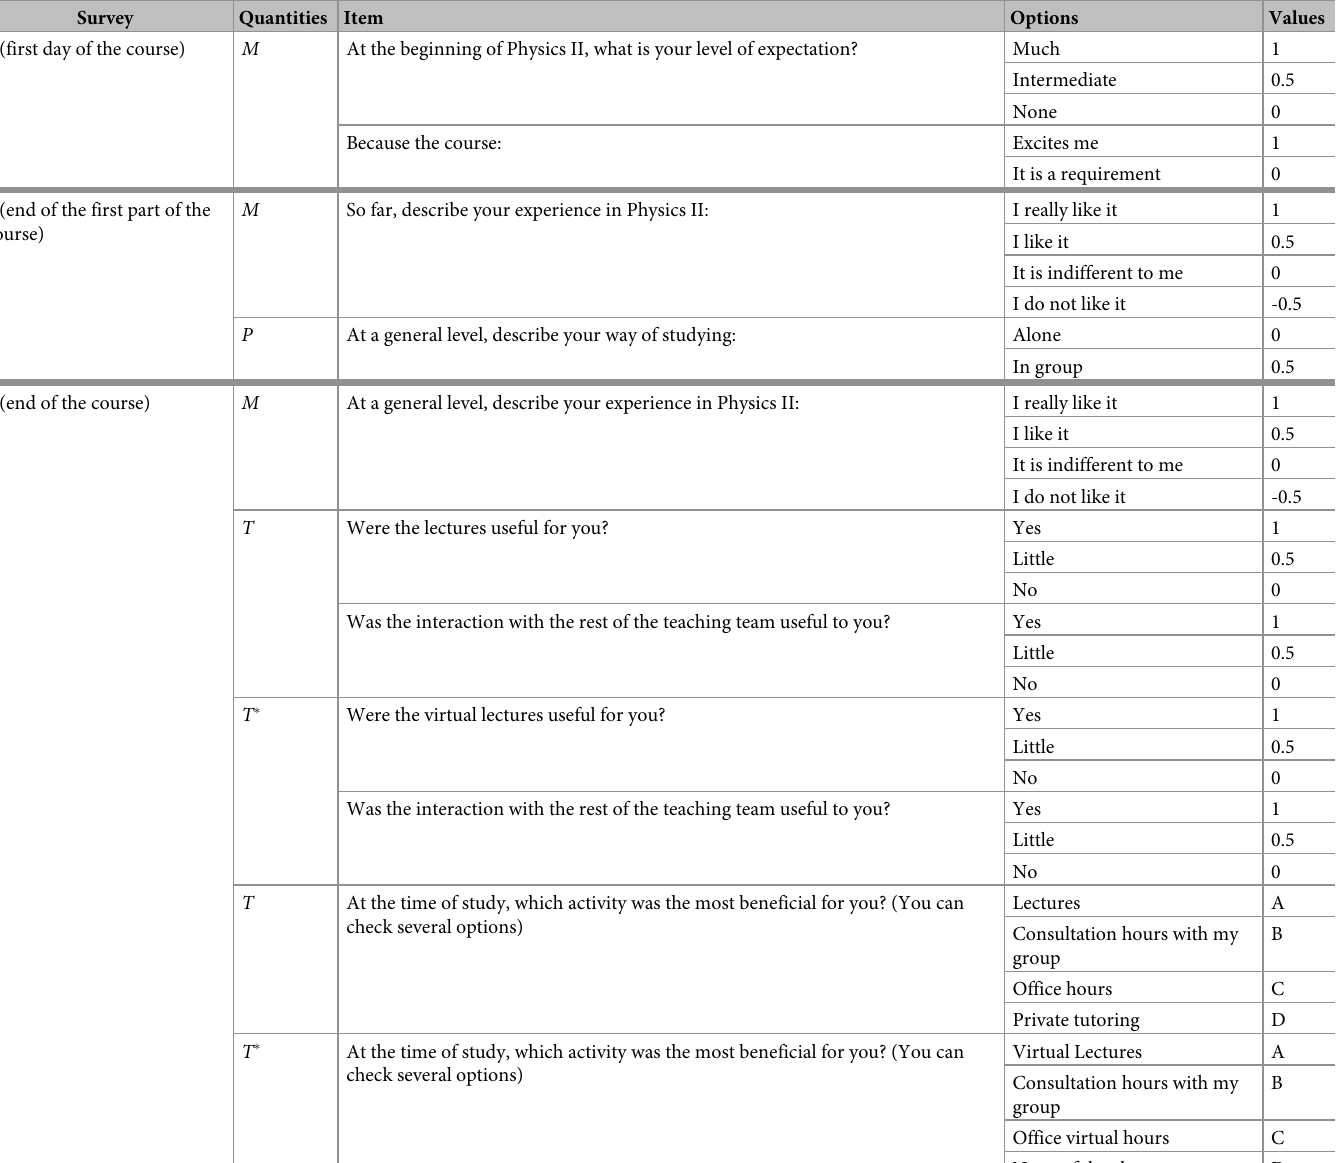
Table 2. Surveys carried out on students during the semester of classes for two years (the duration of this study). Although the surveys were broader, here we only include the questions involved in the model. Survey Quantities